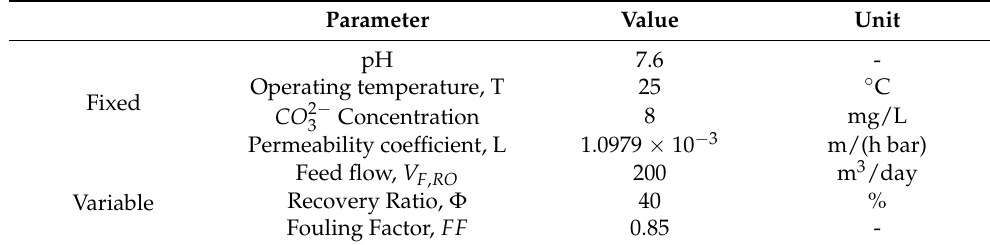
Table 1. Input data of the RO model for one module.